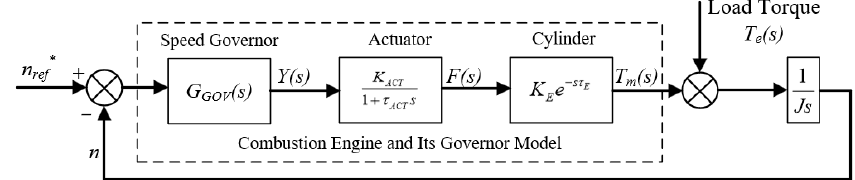
Figure 2. Block diagram of the reduce ‐ order mechanical model for genset.